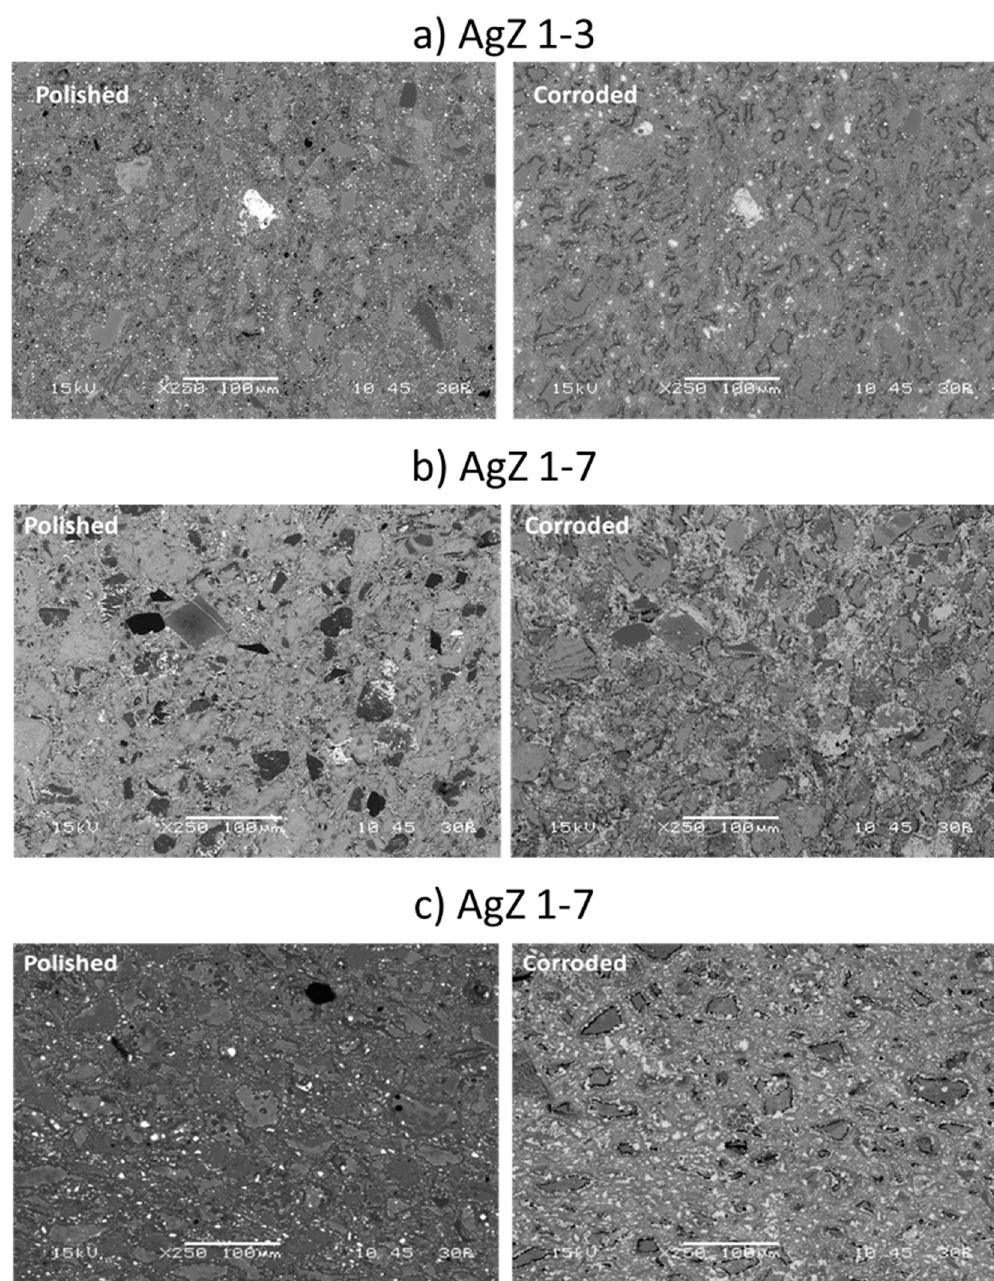
Figure 10. SEM micrographs of the samples both before and after corrosion in pH 11 SPFT experiments: ( a ) AgZ 1-3; ( b ) AgZ 1-7; and ( c ) AgZ 1-8.